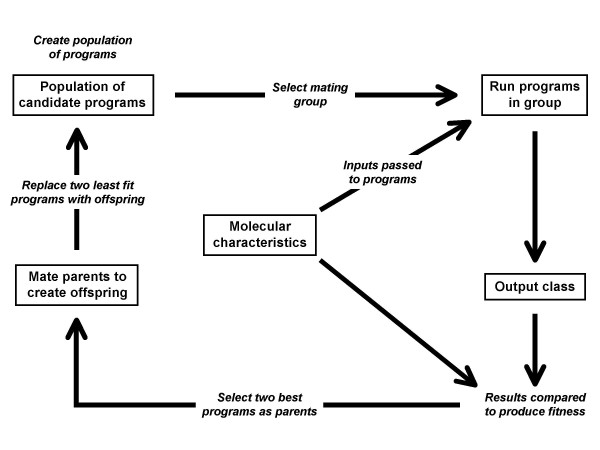
The genetic programming process. This iterative technique was employed on the training set samples to generate classifier rules that were tested on the validation set. Randomly chosen components were initially used to create a population of candidate programs from which a small mating pool of candidate programs was generated. Inputs were passed into these programs and the predicted nodal statuses were evaluated for fitness. The two best performing programs were then mated to produce offspring that replaced the two least fit programs. This process was repeated over many generations to create better programs.